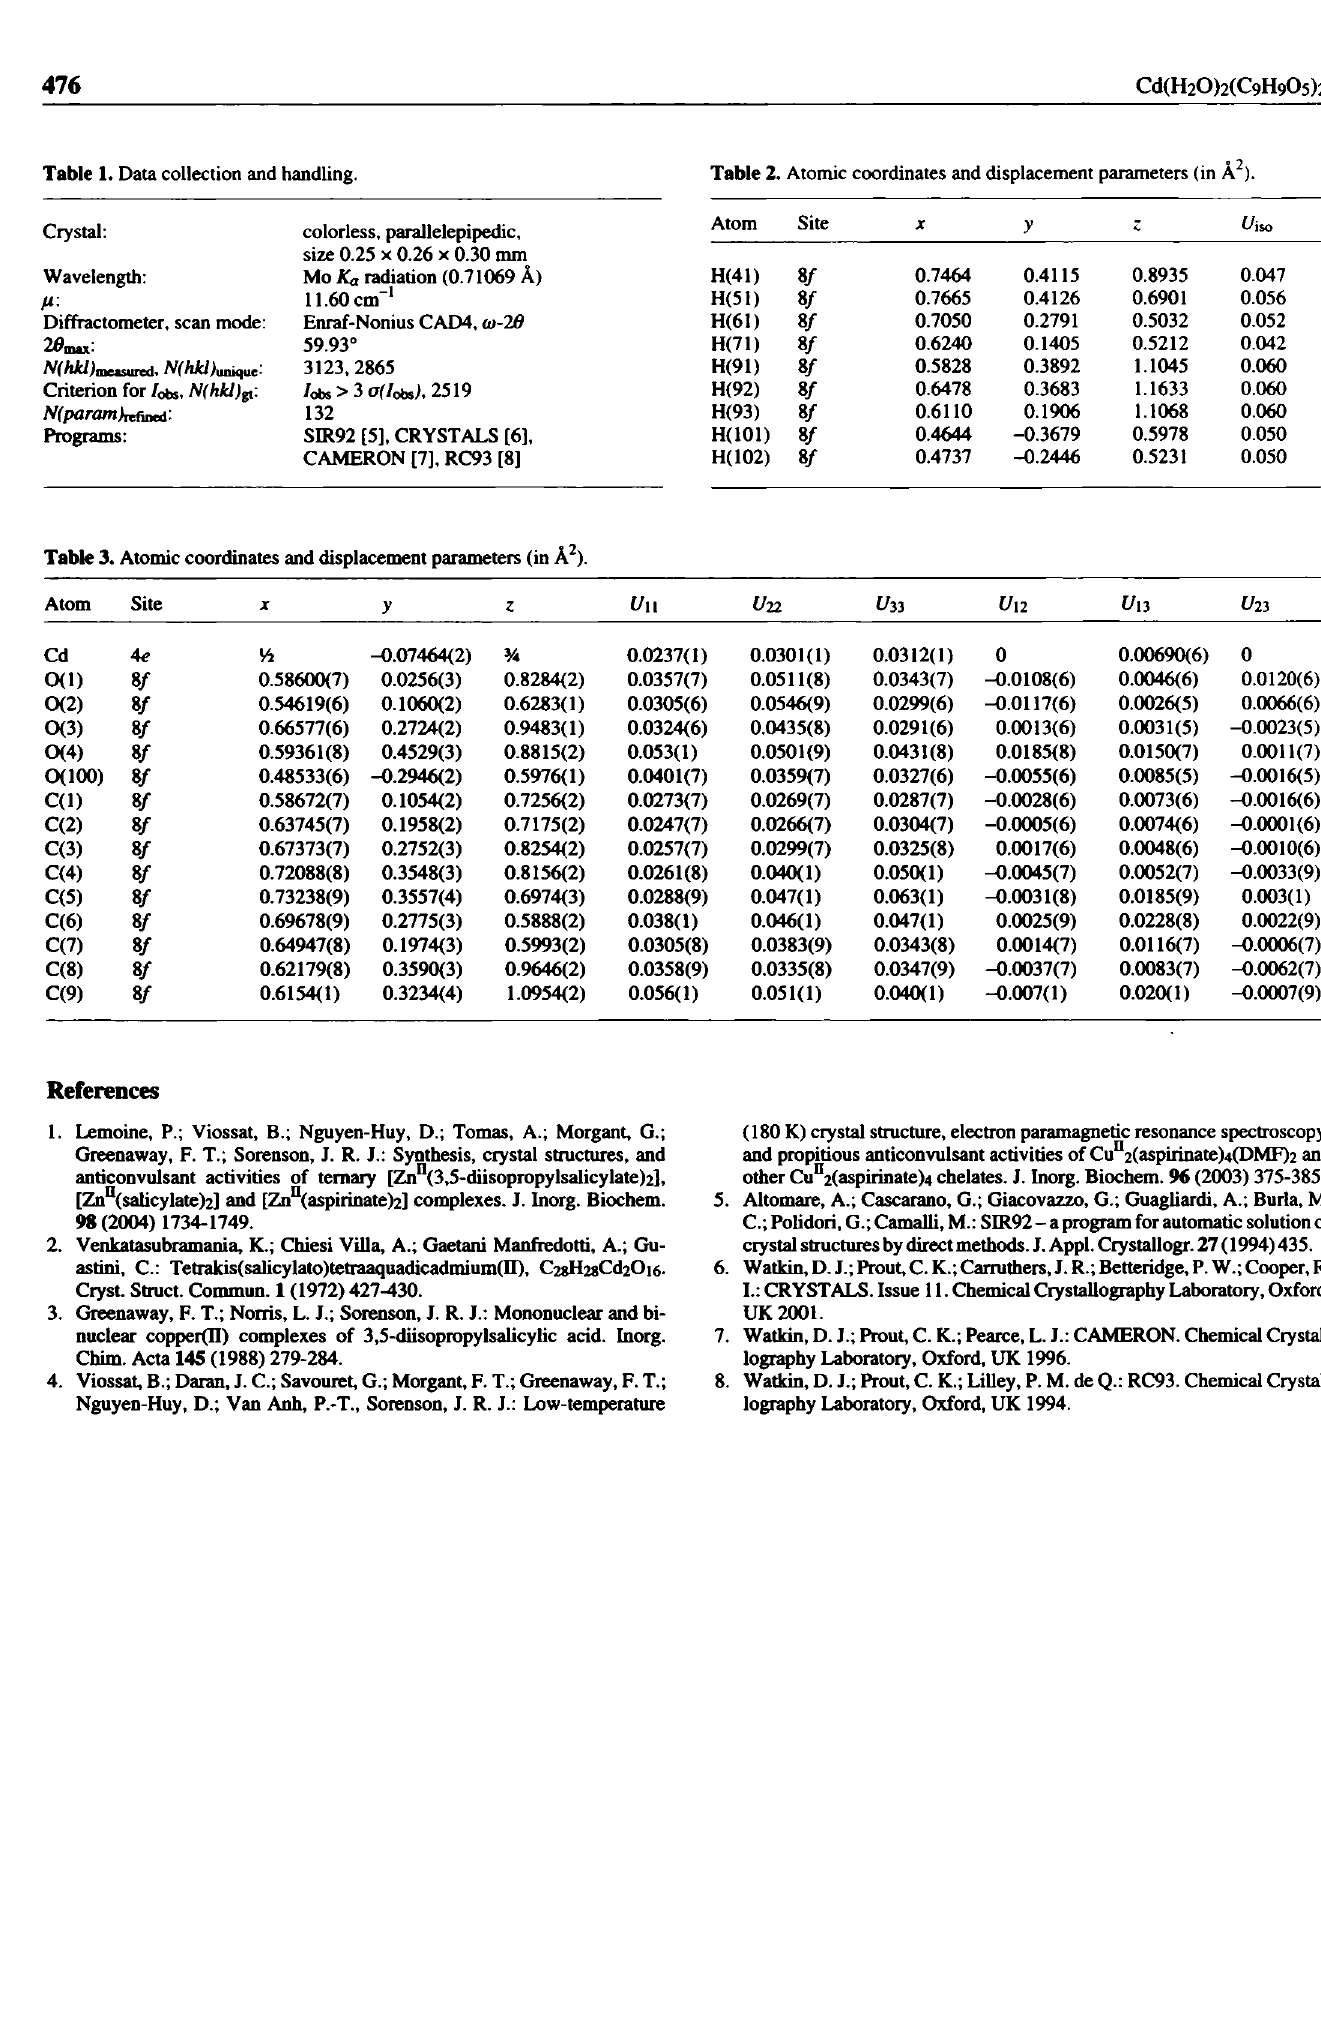
Table 3. Atomic coordinates and displacement parameters (in À 2